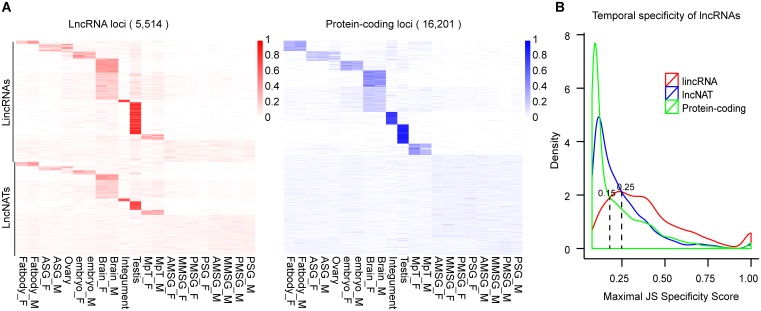
Tissue specificity of lncRNAs and protein-coding genes.(A) Heatmaps of 5,514 lncRNA loci (red; left) and 16,201 protein-coding loci (blue; right) based on normalized expression values (the sum of expression values across all tissues per locus is set to one, using the method described by Cabili, M. N., et al [44]). (B) The distribution of maximal tissue specificity scores for each transcript across 21 tissues.